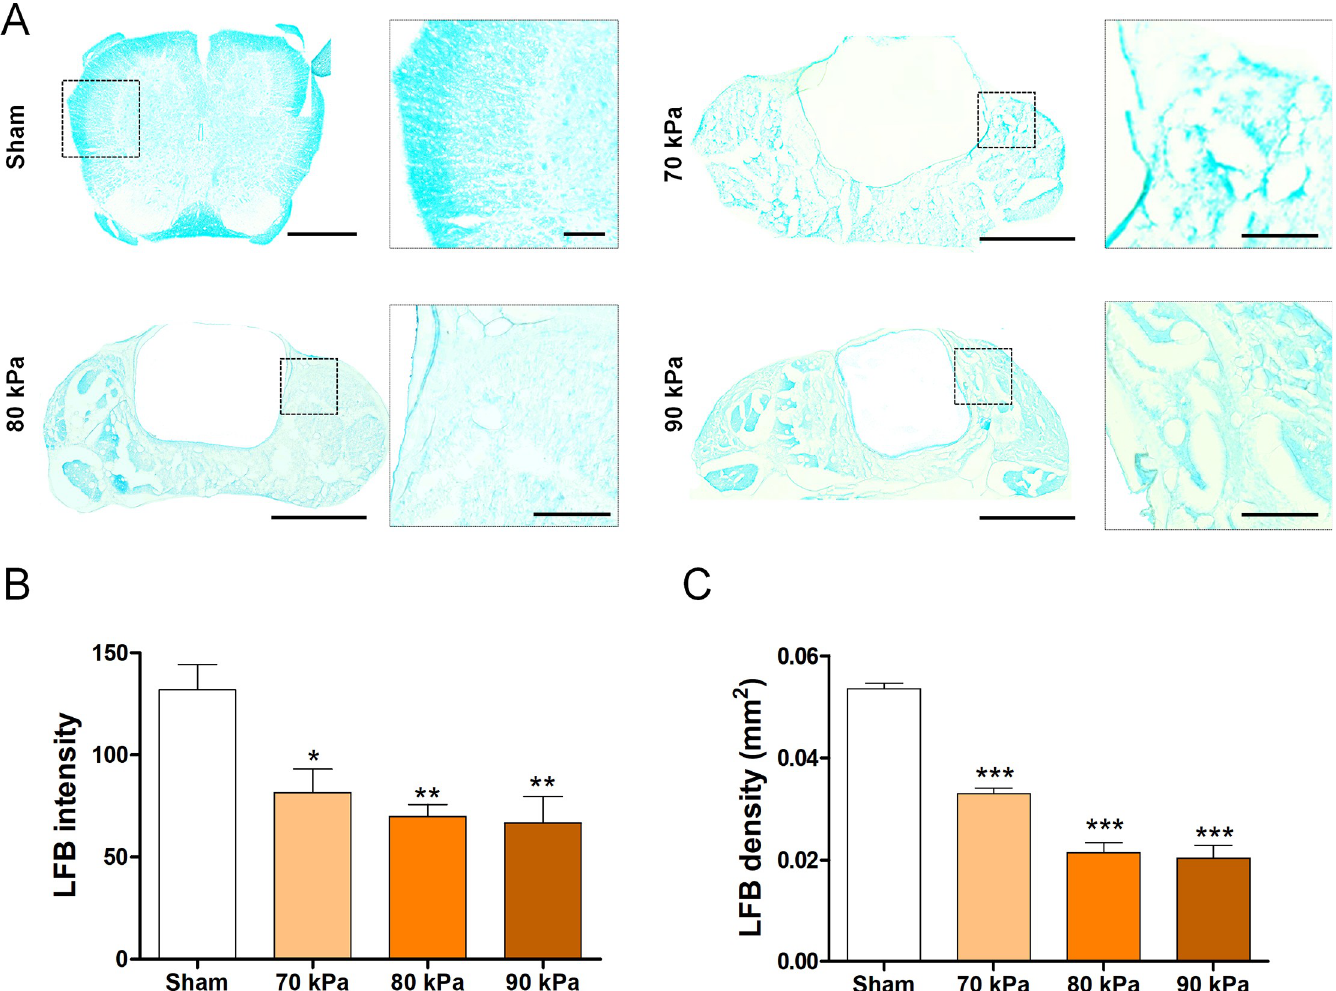
Fig 3. Demyelination assessment using the LSS model. (A) Representative LFB-stained images of the myelin sheath in the sham and LSS groups. Scale bars = 1 mm and 100 μ m. (B, C) Quantitative analyses of (B) pixel intensity and (C) density in LFB-stained myelin sheaths (n = 4 per group). Data are expressed as the means ± SEM. � P < 0.05, �� P < 0.01, and ��� P < 0.001 compared with the sham group analyzed by a one-way ANOVA with Tukey’s post-hoc test.